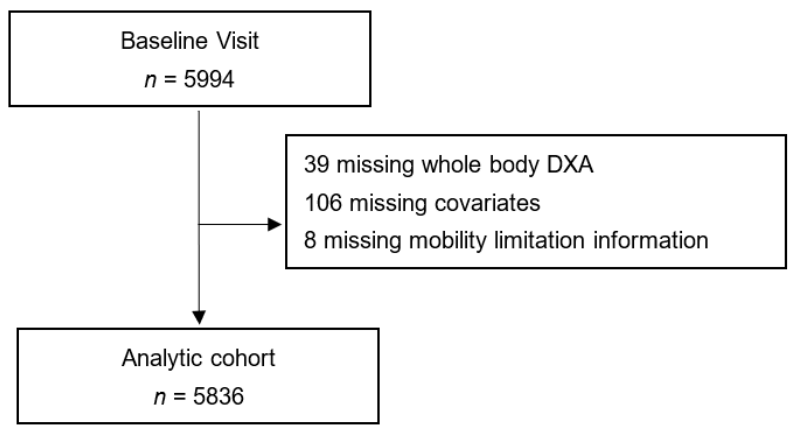
Figure 1. Participant flow chart.